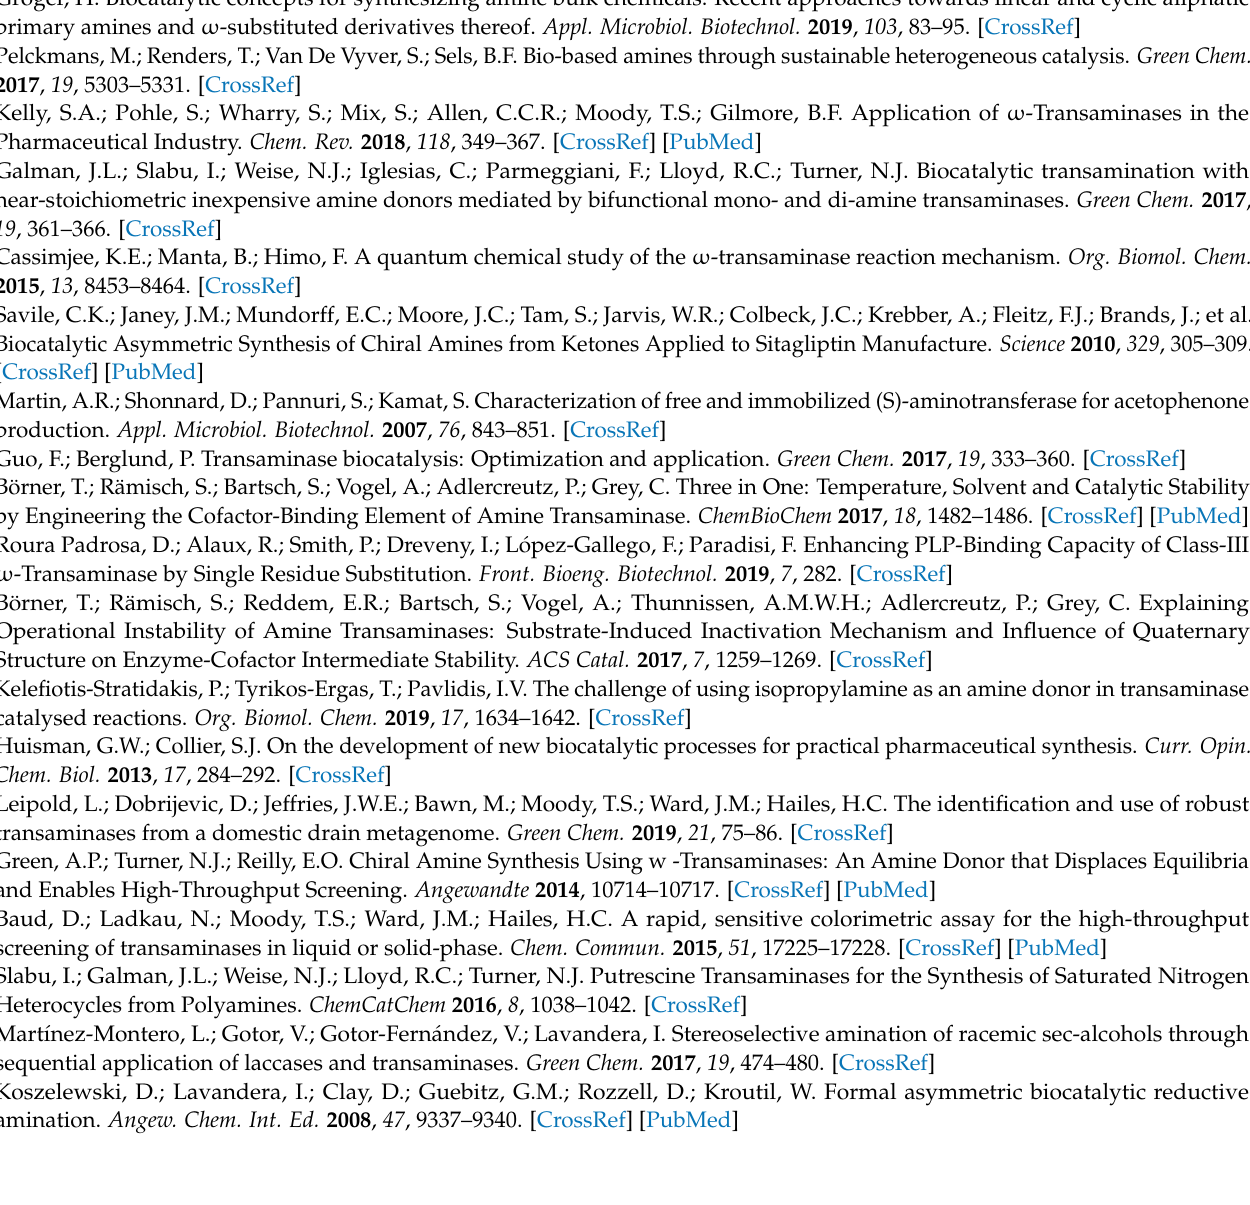
Table S4. Recovered activities and specific activity of the biocatalysts of the three different